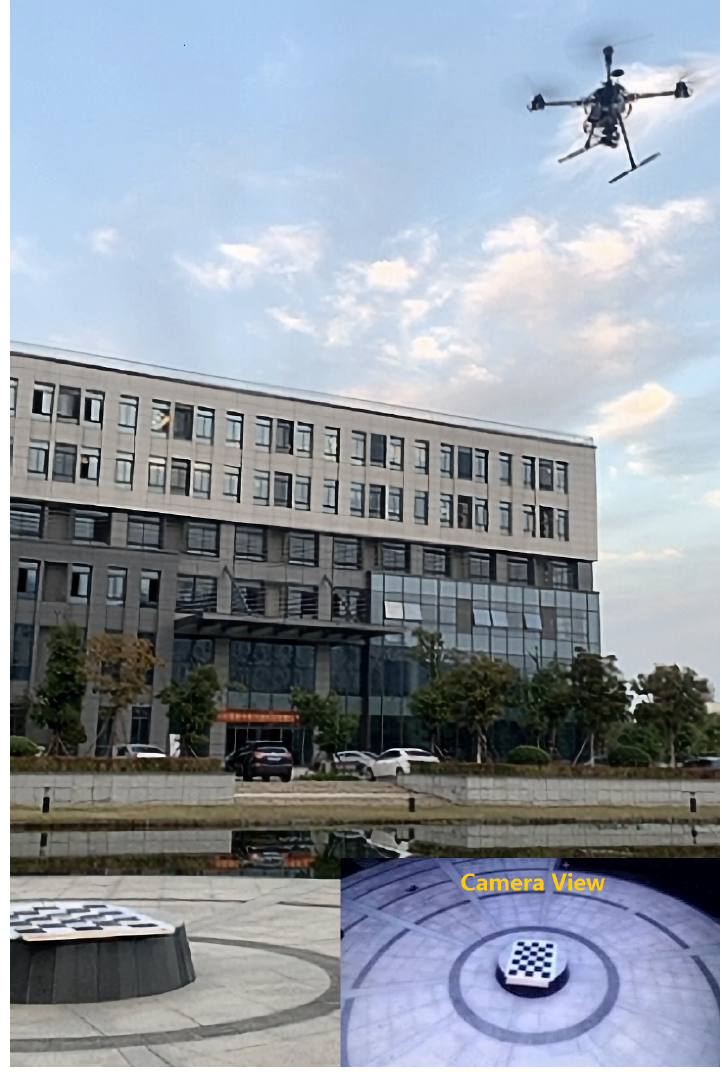
Figure 11. Outdoor experimental